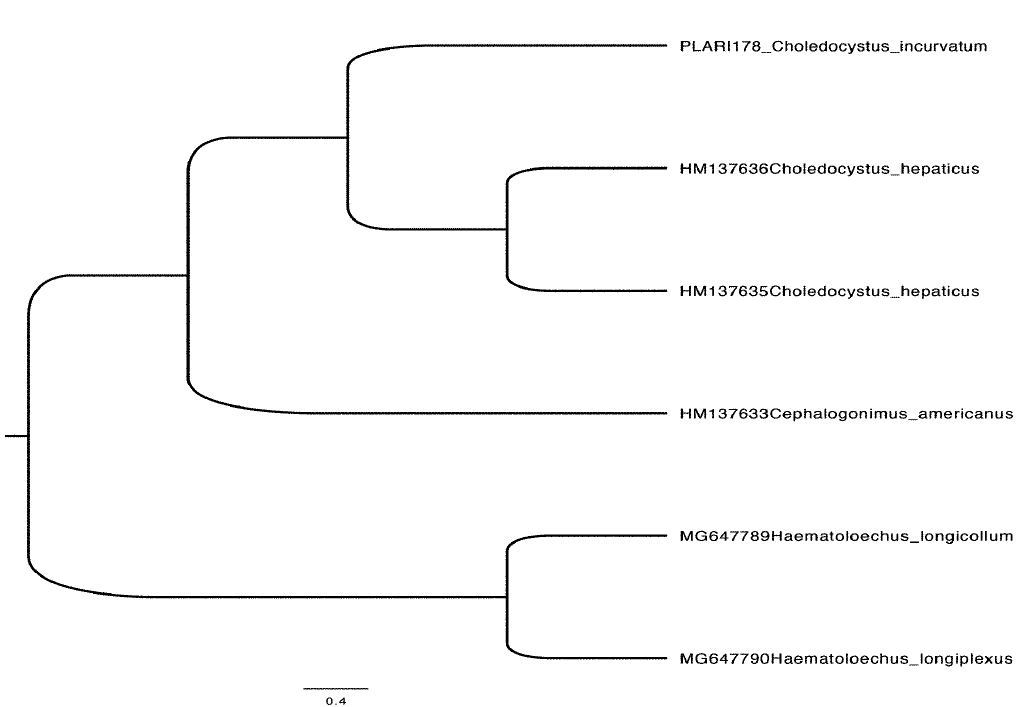
Figure 3. Most parsimonious phylogenetic tree (consistency index = 0.9) of partial COI sequences of Choledocystus incurvatum and close relatives obtained from